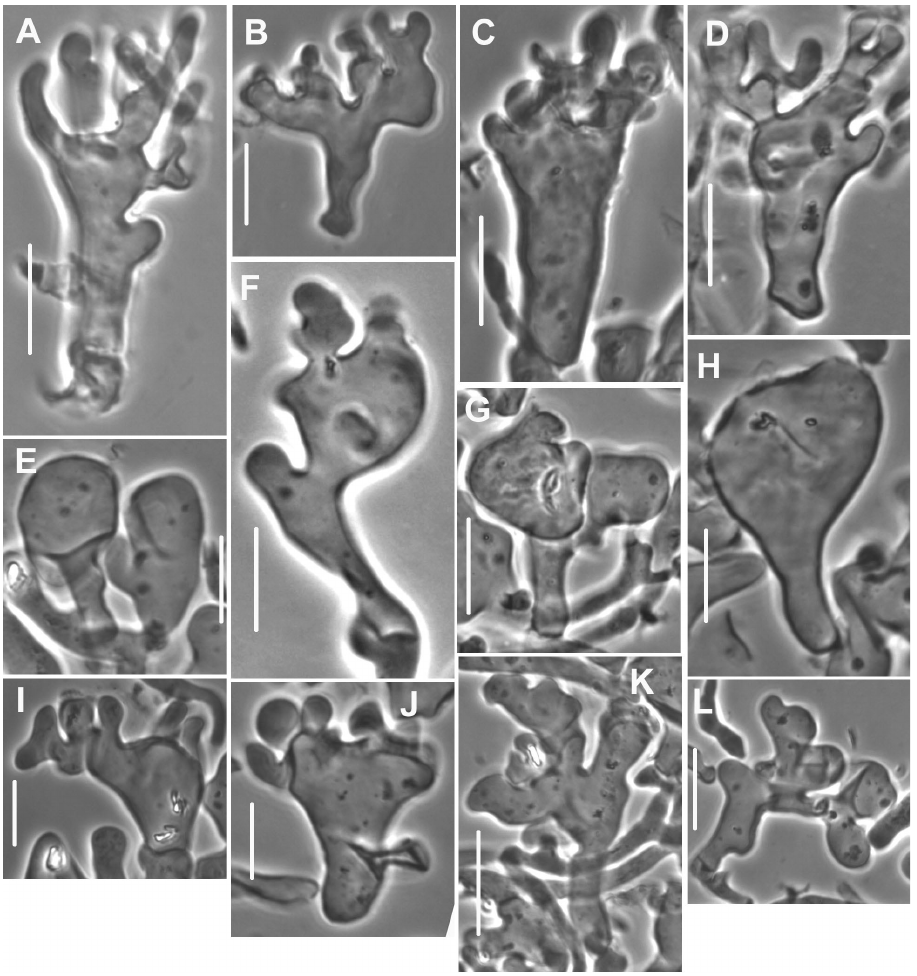
Figure 65. Mycetinis salalis . Pileipellis elements. A–D, F Pileocystidia E, H Inflated elements without growths G, I–L Inflated elements with free-form, lobose outgrowths. Standard bars = 10 µm. TFB 5724 (TENN